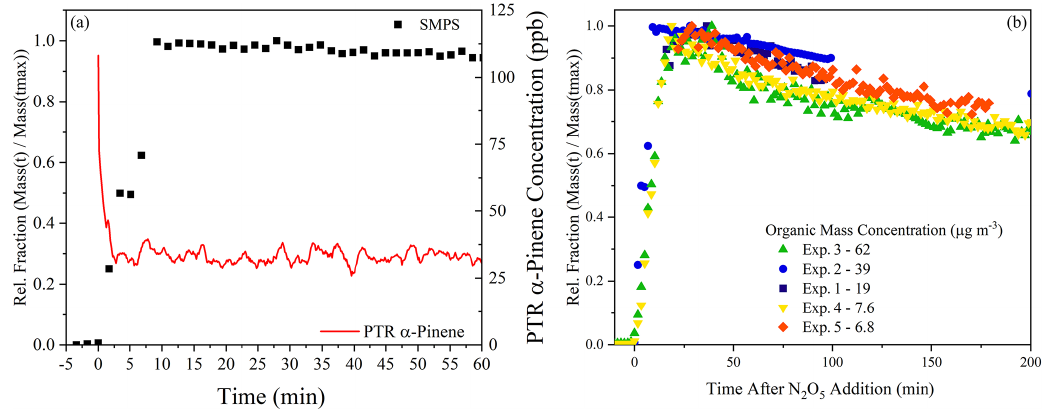
Figure 1. The evolution of precursor and SOA mass. Panel (a) presents an example from Exp. 2, showing prompt SOA formation and consumption of α -pinene. Panel (b) is an overview of all experiments performed, showing the evaporation occurring during dark aging, as measured by the SMPS, and the organic aerosol mass concentration associated with each experiment, all of which have been wall loss